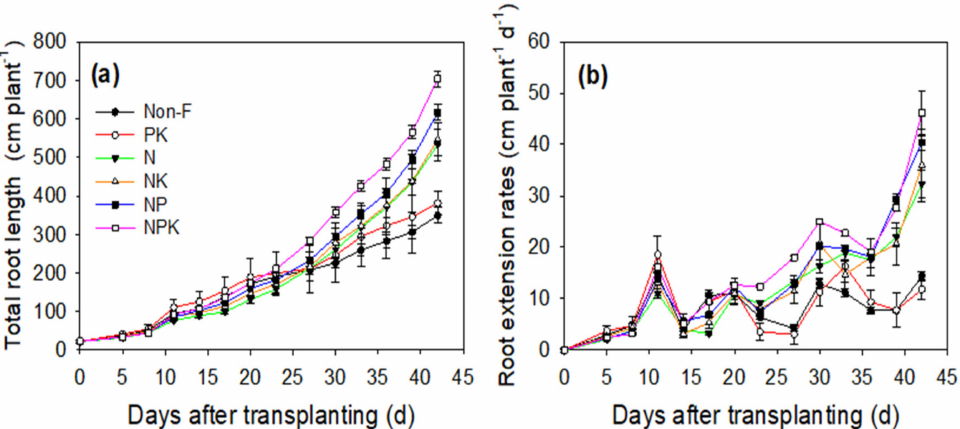
Figure 2. Non − invasive measurements of the total root length per plant ( a ) and root extension rates per plant ( b ) from transplanting stage to 42 d after transplanting in rice plants under various fertilization combinations grown in the rhizo-box experiment. Vertical bars indicate ± SE ( n = 3).